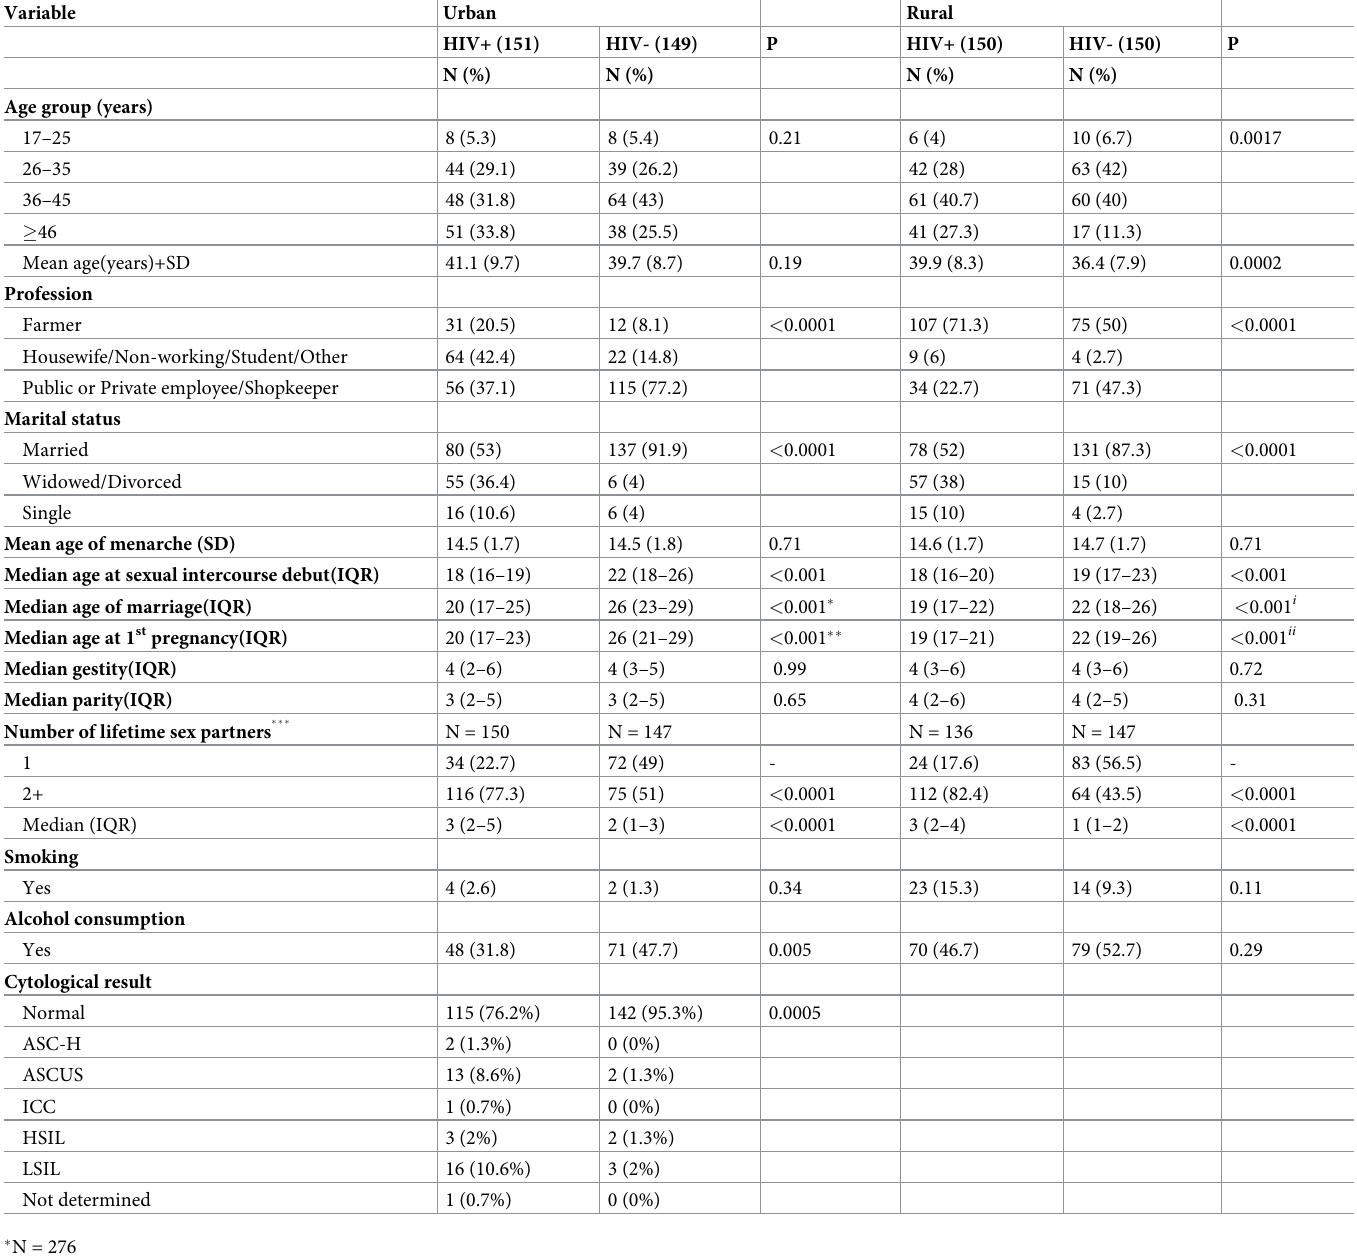
Table 1. Baseline socio-demographic characteristics of the participants by study area and HIV status, among 600 women,